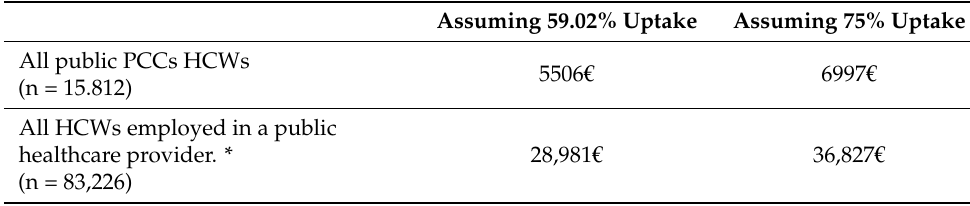
Table 4. Cost of funding the UNICEF incentive in four simulated scenarios.